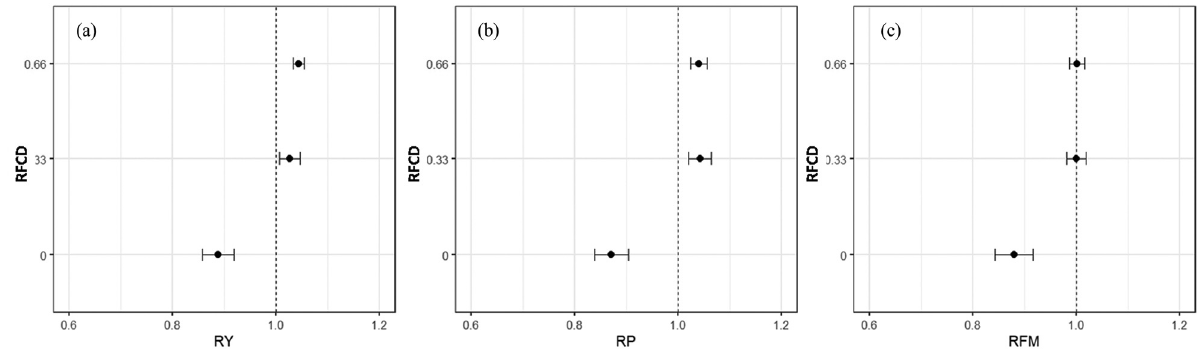
Figure 4: Low - altitude subgroup e ff ect of tobacco RY ( a ) , RP ( b ) , and RFM ( c ) responding to RFCD of